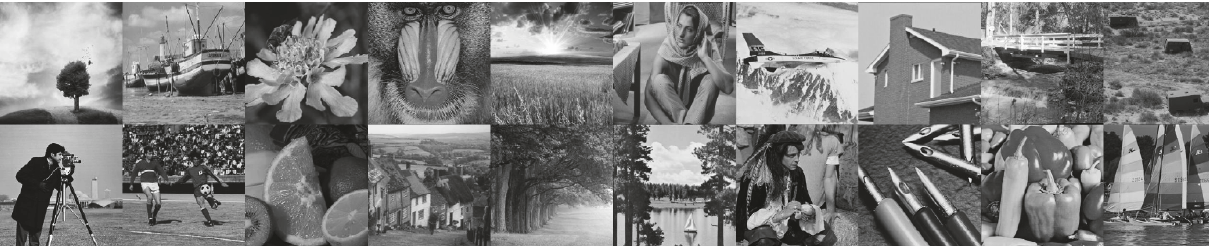
Figure 3: The test images. All are 256 × 256 and will be numbered in order from 1 to 20, from left to right, and from top to bottom.